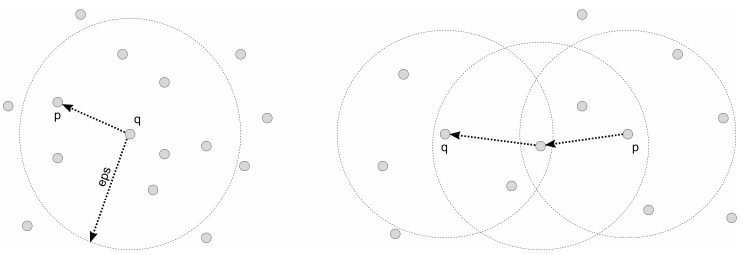
Figure 2. Definition of density-reachable points and density-connected points.